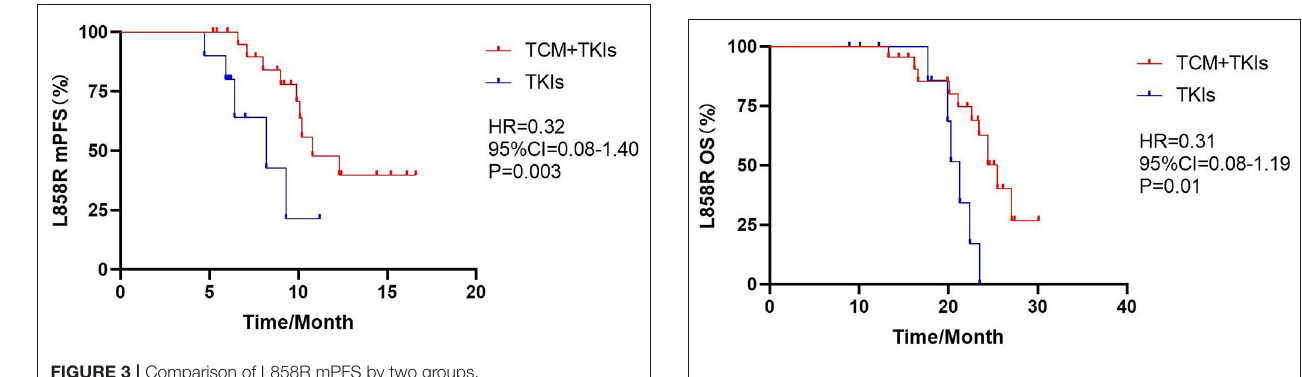
FIGURE 6 | Comparison of L858R mOS by two